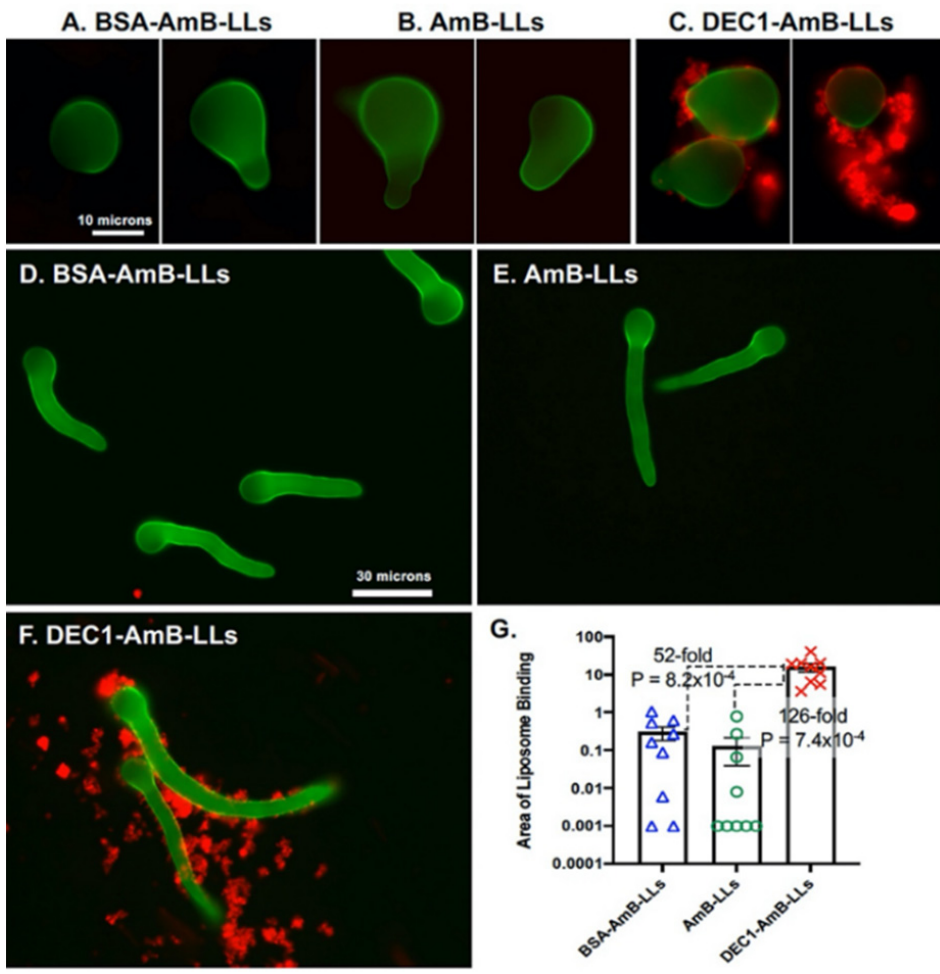
Figure 1. Dectin-1-targeted AmB-loaded liposomes, DEC1-AmB-LLs, bind efficiently to germinating sporangiospores and germlings of R. delemar . ( A – C ) Representative fluorescence images of swollen R. delemar sporangiospores (63 × magnification) on an agar surface are shown. Sporangiospores were either treated with BSA-AmB-LLs ( A ), AmB-LLs ( B ), or DEC1-AmB-LLs ( C ). ( D – F ) Representative fluorescence images of R. delemar germlings (63 × magnification) are shown. Germlings were either treated with BSA-AmB-LLs ( D ), AmB-LLs ( E ), or DEC1-AmB-LLs ( F ). ( G ) The area of red liposome binding (log 10 ) was quantified as shown (N = 9). Standard errors and p -values are included. Size bars indicate 10 and 30 micron scales.